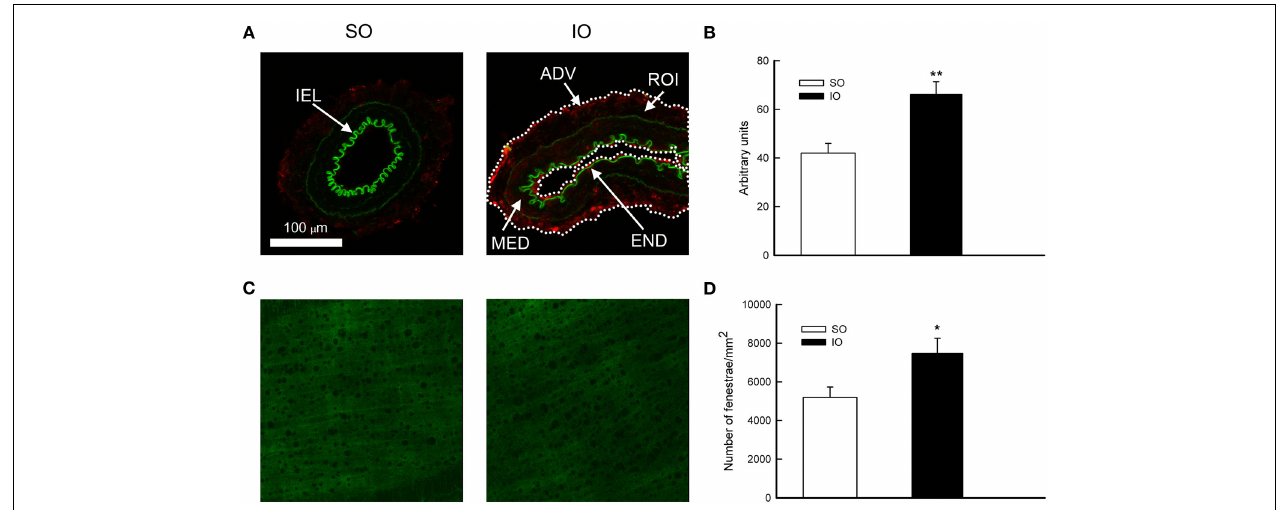
of mesenteric resistance arteries from SO and IO rats. In (C,D) vessels were pressure-fixed at 70mmHg and mounted intact on a slide. Projections were obtained from serial optical sections captured with a fluorescence confocal microscope ( × 63 oil-immersion objective, zoom × 1). Image size, 238 μ m × 238 μ m.Values are the mean ± SEM of n = 5–6. * P < 0.05 by unpaired Student’s t -test.